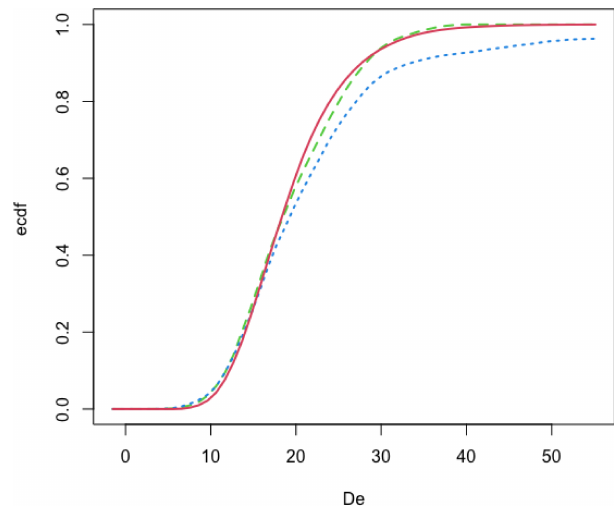
Figure 5. Comparison of the cumulative distribution functions: A × D r (red line), D e (dotted blue line), and reduced – after removal of the detected outlier values – D e (dashed green